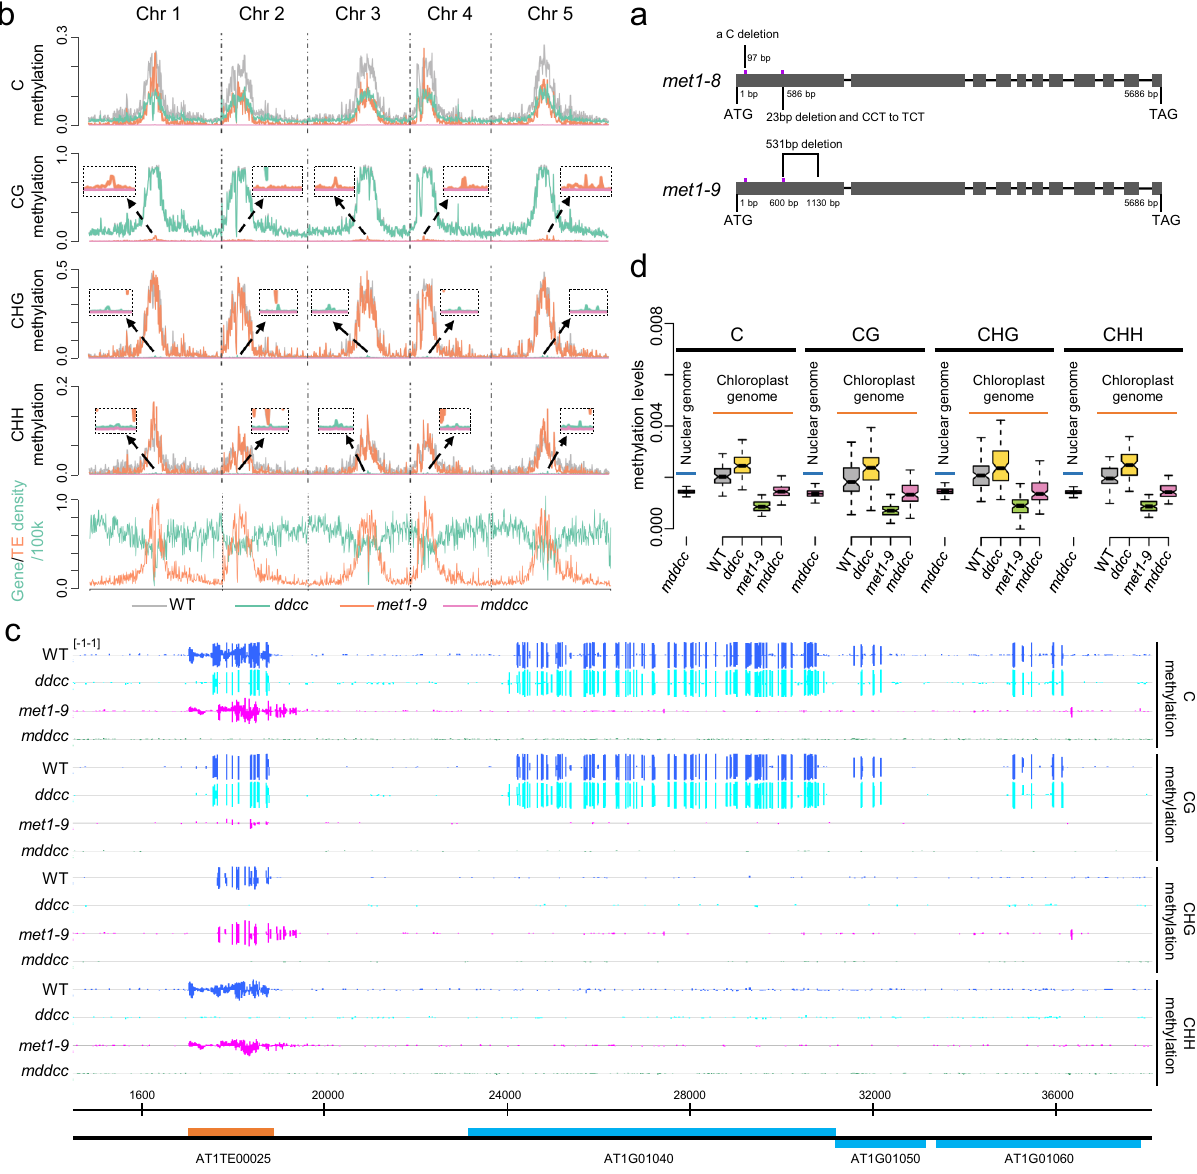
Fig. 1 DNA methylation is eliminated in the mddcc mutant. a Diagrams of the MET1 gene showing the mutation sites in met1-8 (upper) and met1-9 (lower) mutants. Purple bars indicate the position of the sgRNAs used. b Genome-wide distribution of DNA methylation in all three sequence contexts in the indicated mutants. Wireframes are zoom-in of the indicated regions. Biological replicates were combined as one sample. Independent biological replicates are shown in Supplementary Fig. 2a. It should be noted that the lines of the WT overlap with those of ddcc in the mCG row. c Screenshot of DNA methylation levels over one representative locus in the indicated mutants. Orange and blue bars indicate TEs and genes, respectively. TEs and genes oriented 5 ′ – 3 ′ and 3 ′ – 5 ′ are shown above and below the line, respectively. Biological replicates were combined as one sample. Independent biological replicates are shown in Supplementary Fig. 2b. d Comparison of the DNA methylation levels between nuclear and chloroplast genomes in the indicated genotypes. Biological replicates were combined as one sample. Independent biological replicates are shown in Supplementary Fig. 2c. The horizontal line within the box represents the median; the whiskers represent minimum and maximum values; and the lower and upper boundaries of the box represent the 25th and 75th percentiles, respectively. the DNA methylation levels of the nuclear genome with those of wide to this epigenetic modi fi cation (Fig. 1d and Supplementary the methylation-free chloroplast genome. Noticeably, the DNA Fig. 2c). Thus, the mddcc mutant is a DNA methylation-free methylation of the nuclear genome in mddcc was as low as that of Arabidopsis genotype. the chloroplast genome in any mutant background in all three sequence contexts (Fig. 1d and Supplementary Fig. 2c), indicating DNA methylation regulates gene expression in a dose- that MET1, DRM1, DRM2, CMT3, and CMT2 are responsible for the maintenance of the entire DNA methylation in the Arabidopsis genome, and implying that additional yet-to-be- plementary Fig. 3a and Supplementary Table 2). By analyzing described DNA methyltransferases do not contribute genome- differentially expressed genes relative to WT (DEGs; fold change NATURE COMMUNICATIONS| (2022) 13:1335